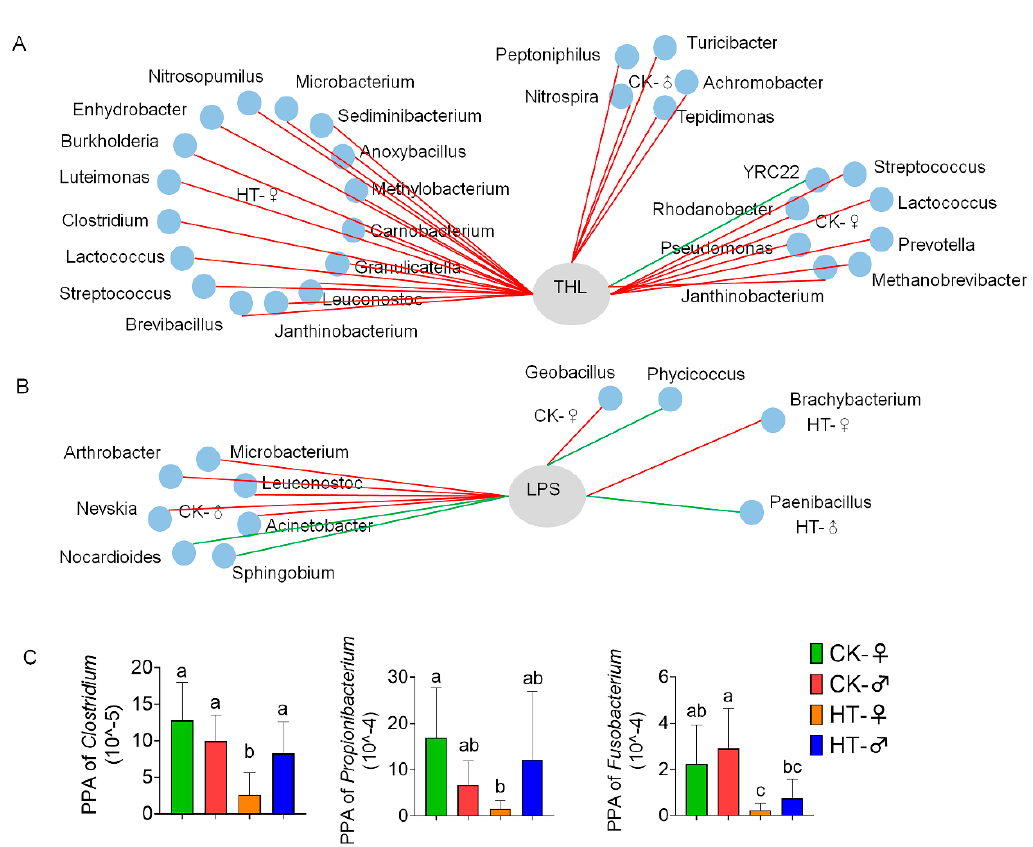
Figure 6. High temperature affects digestive enzymes and nutrient metabolism through the silk- worm gut microbes. ( A ) Analysis of the correlation between THL activity in the silkworm digestive juice and the intestinal microbes of the silkworm. ( B ) Correlation analysis between LPS activity in silkworm digestive juice and intestinal microbes. Each co-occurring pair among the microbial pop- ulations and metabolites has an absolute Spearman rank correlation above 0.90 (red line: positive correlation (R > 0.90); green line: negative correlation (R < − 0.9)) with an FDR-corrected significance level under 0.5. ( C ) Changes in the abundance of bacteria at the genus level after 72 h high-temper- ature treatment. PPA stands for phylum-level proportional abundance. Bars with different letters are significantly different ( p < 0.05).